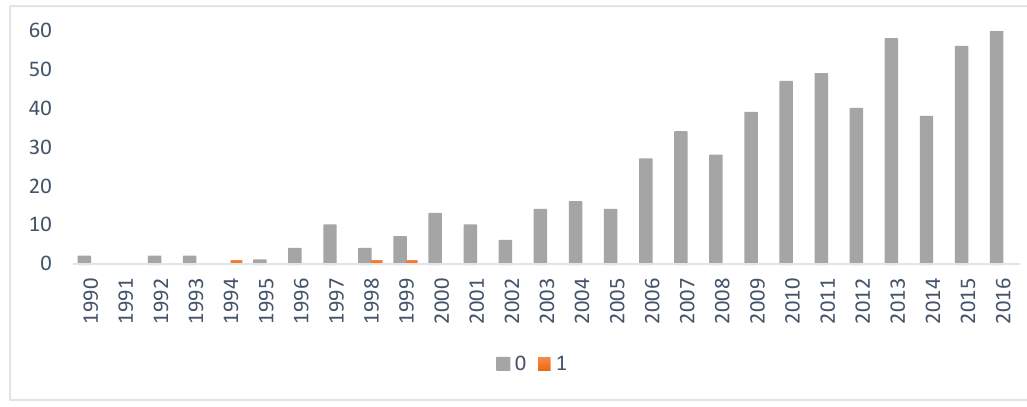
Figure 7. Number of normal (0) and slight (1) canine elbow dysplasia (CED) results by birth year in the reference population. 0: Normal; 1: Slight.